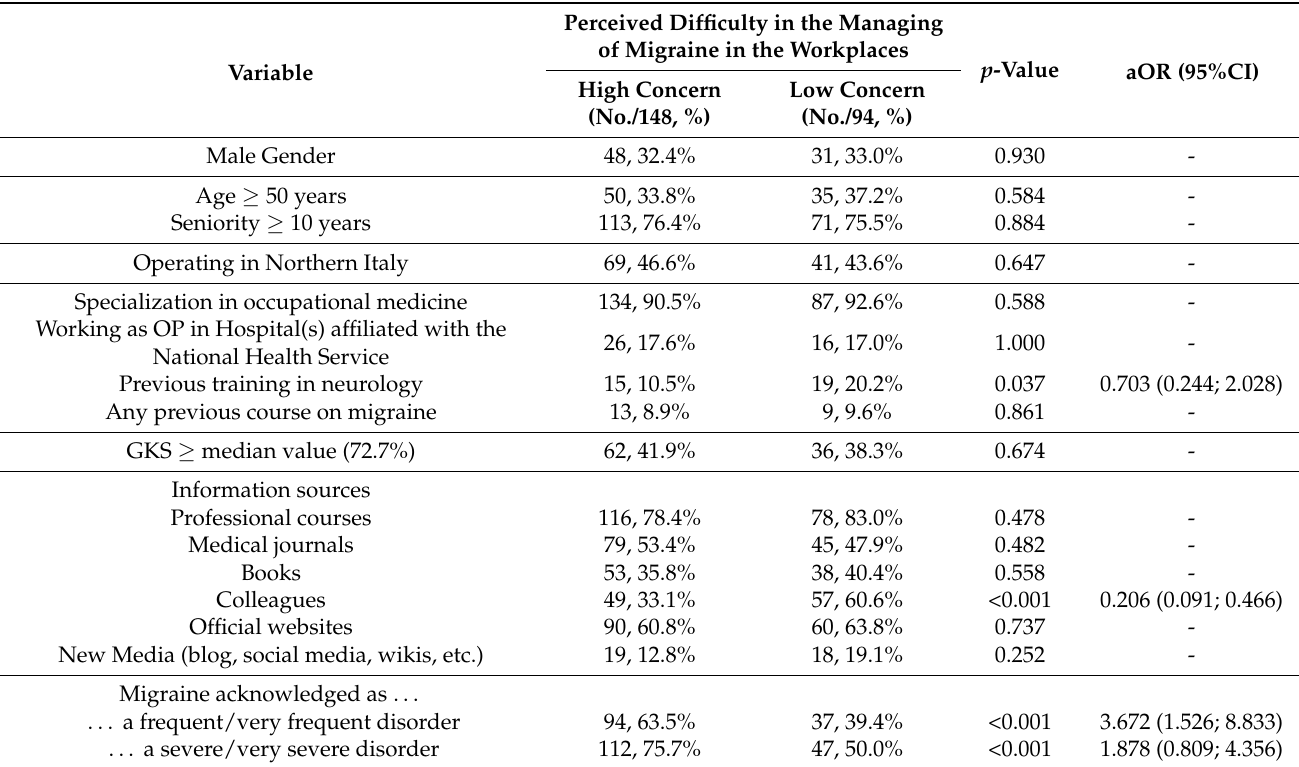
Table 5. Analysis of factors that in participating Italian occupational physicians (No. = 242) were asso- ciated with greater perceived difficulty in the managing of migraine in the workplaces. Comparisons were performed by means of chi squared test. All factors that, in univariate analysis, were associ- ated with the outcome variable of higher concern regarding the managing of migraine ( p < 0.050) were included a logistic regression analysis model as explanatory variables, with calculation of corresponding adjusted odds ratios (aOR) and their respective 95% confidence intervals